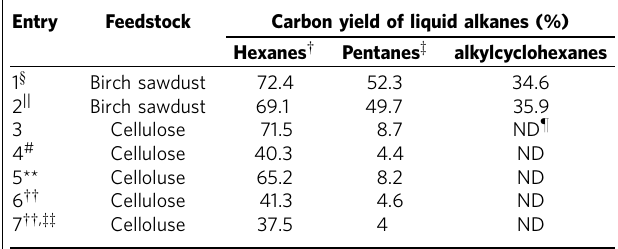
Table 3 | Summary of direct hydrodeoxygenation of birch sawdust and cellulose under various reaction conditions over Pt/NbOPO 4